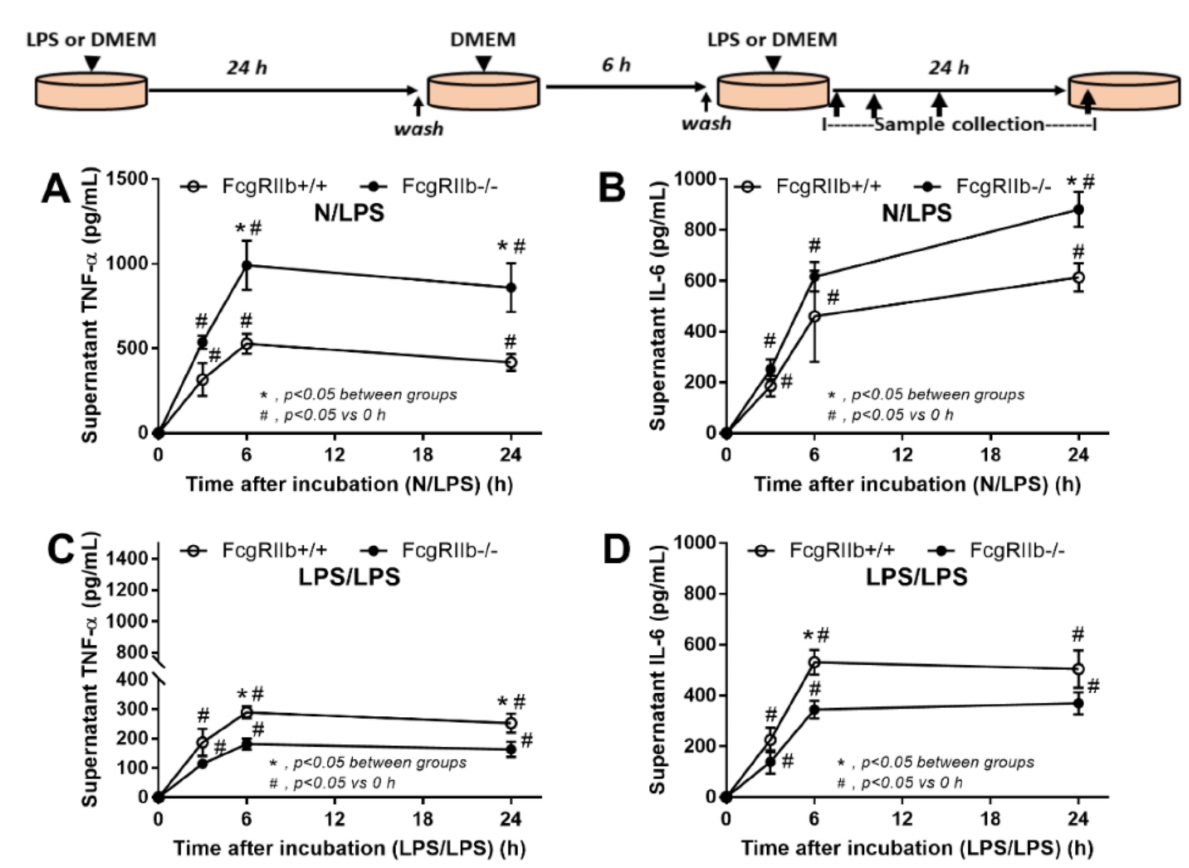
Figure 7. Schema of the in vitro experiments (see method) is demonstrated (upper part of figure). Supernatant cytokines secreted by macrophages from FcgRIIb-/- lupus mice and wild-type (FcgRIIb+/+) mice after 6 h incubation with a single lipopolysaccharide stimulation (N/LPS) ( A , B ) or stimulation twice (LPS/LPS) ( C , D ) are demonstrated. Independent triplicate experiments were